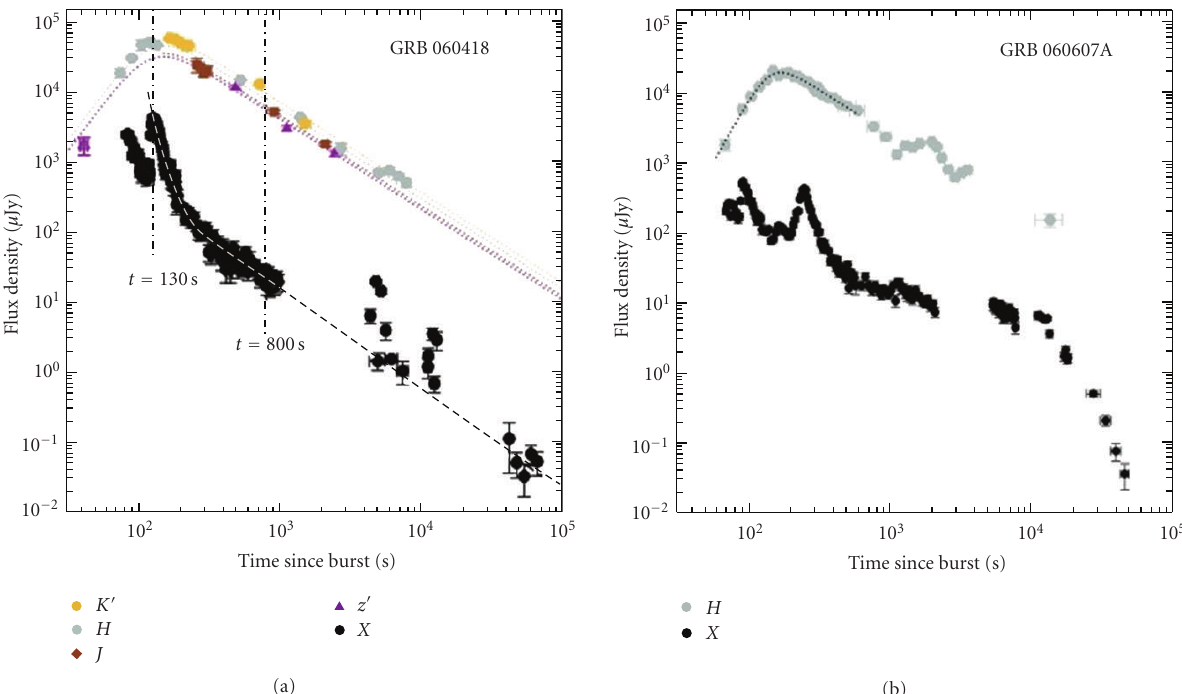
Figure 1: NIR and X-ray light curves for GRB 060418 and GRB 060607A.